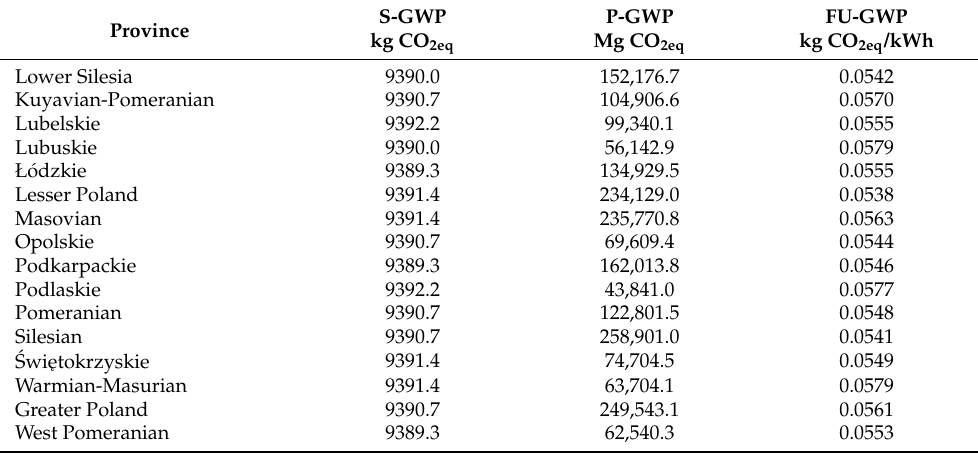
Table 3. Results of GWP indicator calculation: S-GWP—GWP indicator calculated for a PV system of 5.72 kWp, kg CO 2eq ; P-GWP—GWP indicator calculated for installations built during 2019 and